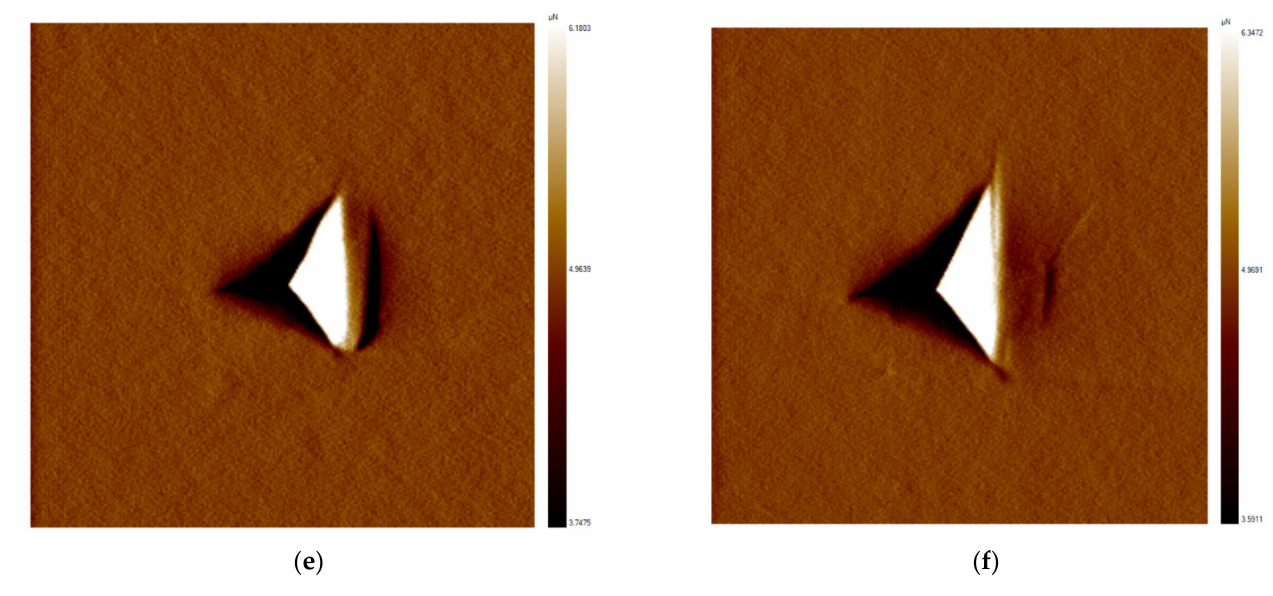
Figure 6. AFM scan of indentation of lithium niobate crystal with different low loads. ( a ) 300 µ N; ( b ) 500 µ N; ( c ) 1000 µ N; ( d ) 5000 µ N; ( e ) 8000 µ N; ( f ) 10,000 µ N. The indentation depth was 0.09 µ m at 8 mN and 0.105 µ m at 10 mN, as shown in Figure 7. In order to study the critical pressure and indentation depths of brittle plastic de- formation of lithium niobate crystals, high load nanoindentation was used for experiments.